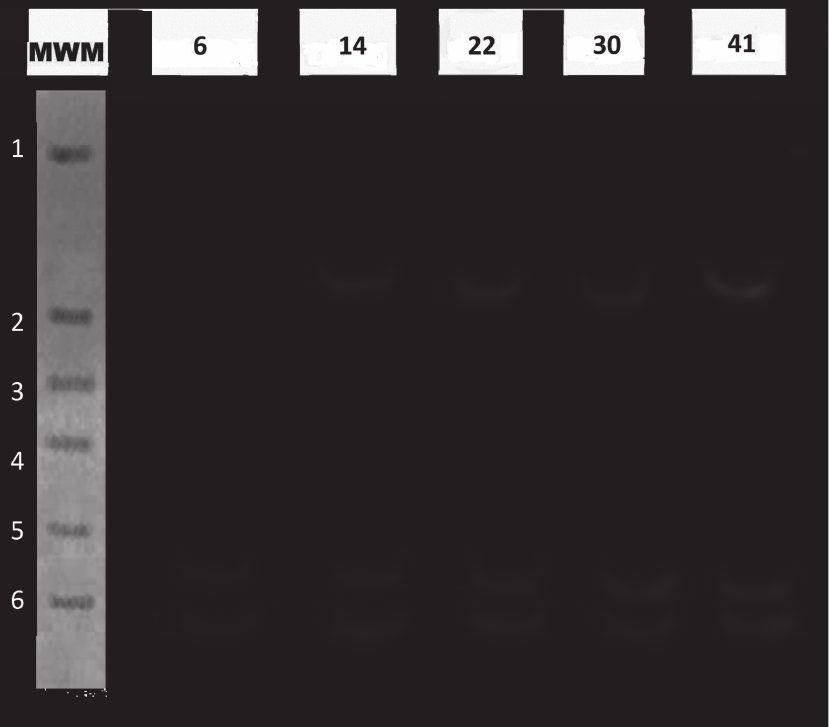
Fig. 4. Zymograms of digestive proteases during ontogeny of Parachromis dovii larvae a SDS–PAGE for alkaline proteases. MWM: Marker of molecular weights, 1) phosphorylase b (97 kDa), 2) serum bovine albumin (66 kDa), 3) egg albumin (45 kDa), 4) carbonic anhydrase (29 kDa), 5) trypsinogen (24 kDa), and 6) soybean trypsin inhibitor (20